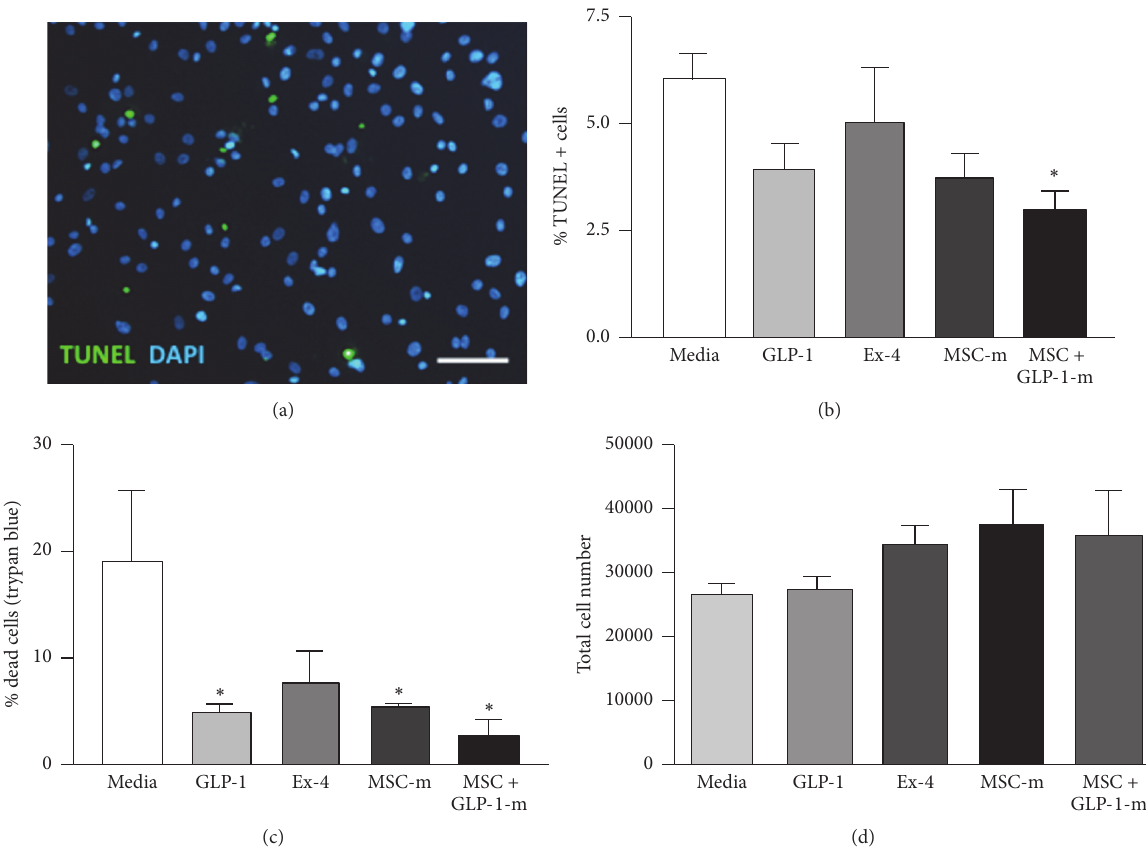
Figure 1: Effect of GLP-1 CellBeads on apoptosis and viability of ischaemic human cardiomyocytes. (a) Apoptosis was assessed using TUNEL staining. Scale bar = 50 𝜇 m. (b) 24 hours after ischaemia, MSC-GLP-1 conditioned media significantly reduced apoptosis compared to media alone. GLP-1, Exendin -4, and MSC media showed no significant reduction in apoptosis as assessed by TUNEL. (c) Cardiomyocyte viability was determined using trypan blue dye exclusion assay. GLP-1, MSC conditioned media, and MSC-GLP-1 conditioned media improved cell viability compared to media alone, 48 hours after ischaemia. (d) Ischaemic cell viability determined by cell number was increased with all agonists, compared with media alone; however this was not significant. 𝑁 = 4 per group ∗ 𝑃 < 0.05 versus media